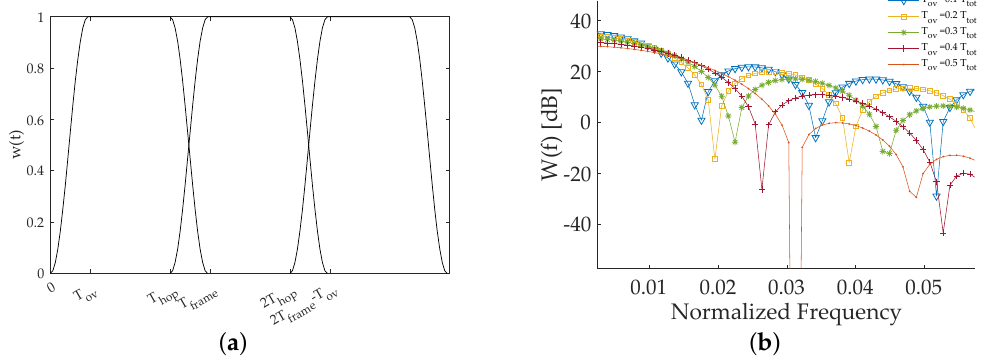
Figure 4. Window function implemented to diminish the computational burden of the data fusion algorithm working on sensor: ( a ) Time-domain working principle of the OLA mechanism and ( b ) window spectral properties for overlapping fraction spanning in the interval [0.1; 0.5].